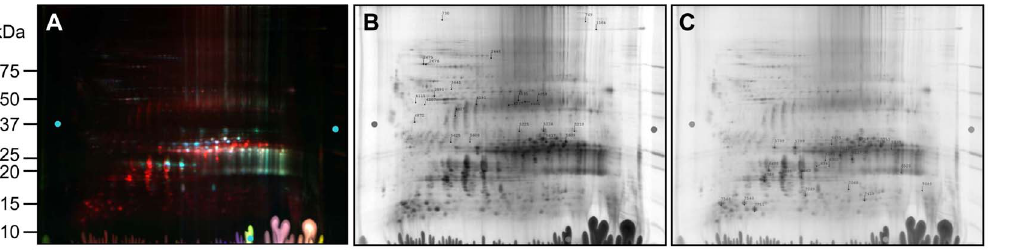
Figure 5. 2D-DIGE analysis of proteomic changes in whole lenses of 14-day-old mice induced by knock-in of the a A-R49C mutation. (A) A 2D gel of lens proteins labeled with cyanine dyes derived from WT1 proteins labeled with Cy2, WT2 proteins labeled with Cy3, and a A-R49C homozygous lens proteins labeled with Cy5. (B, C) Protein spots that were selected for analysis from the gel in (A) are shown. Proteins were identified by tandem mass spectrometry and Mascot searches of spots that were selected from the gels. Quantitative image analysis and mass spectrometry data for the identified proteins from these gels are listed in Table 3.